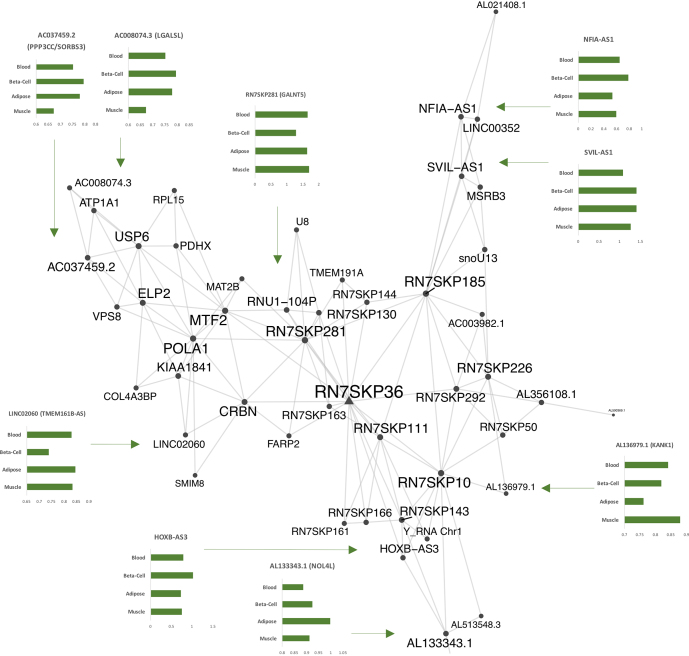
A noncoding RNA network is positively linked to peripheral insulin sensitivity and translational control. Probabilistic networks are utilized to establish a causal relationship between molecules and disease (5). We utilized the response to diverse forms of treatment aimed at reversing insulin resistance, along with measured fasting relationships to estimate if planar filtered networks (77), based on data from 191 individuals, were enriched in genes dynamically regulated or were lncRNAs, harbored causal genetic variant related to metabolic disease, or dominated by proven T2DM disease pathways. MEGENA (77) was used to identify discrete planar filtered networks using the CORE-IS gene list as input (FDR<1% and spearman gene correlation; P< 0.01 for module significance and P< 0.01 for network connectivity). Protein–protein interaction analysis (79) facilitated the interpretation of the identified networks while providing additional biological plausibility to each module (78). Node and label size are proportional to the node degree value within each distinct module. This, the fourth large discrete planar filtered network was dominated by non-coding RNAs (49 genes, 70% ncRNA, and 84% of the network members positively co-varying with in vivo IS). Thirteen of the ncRNA had cis antisense expressed protein-coding genes and these 13 genes, along with the remaining 30% protein-coding CORE-IS genes in the network, formed a protein–protein interaction network strongly associated with viral responsive protein-coding genes (P< 1 × 10−48) and translational initiation (P< 1 × 10−37). The network included several shorter ncRNAs, including the highly conserved 7SK ncRNA pseudogenes which are 271 to 326 base-pairs long. The function of these is unknown despite the 7SK ncRNA gene itself being described half a century ago. 7SK RNA binds to HEXIM1 to inhibit the positive transcription elongation factor b (P-TEFb)—transcript elongation (HEXIM1 is negatively associated with IS, Table 2 (140) and also regulated by a lncRNA (141).